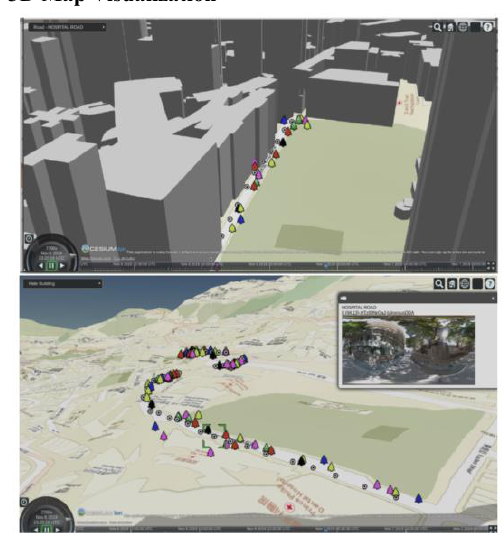
Figure 19. The distribution of detected trees along the Hospital road in 3D Map